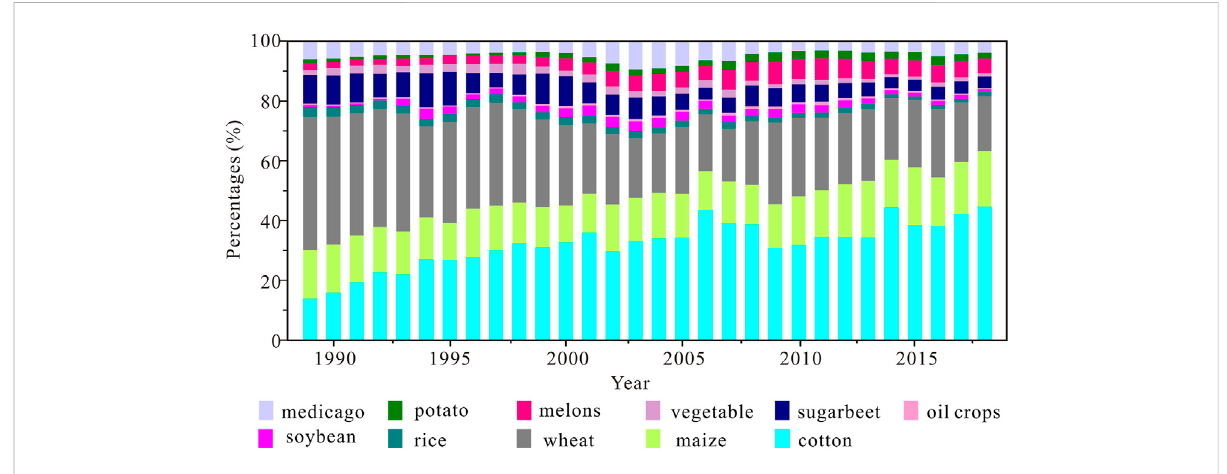
FIGURE 5 Percentages of crop planting scale in Xinjiang from 1989 to 2018.